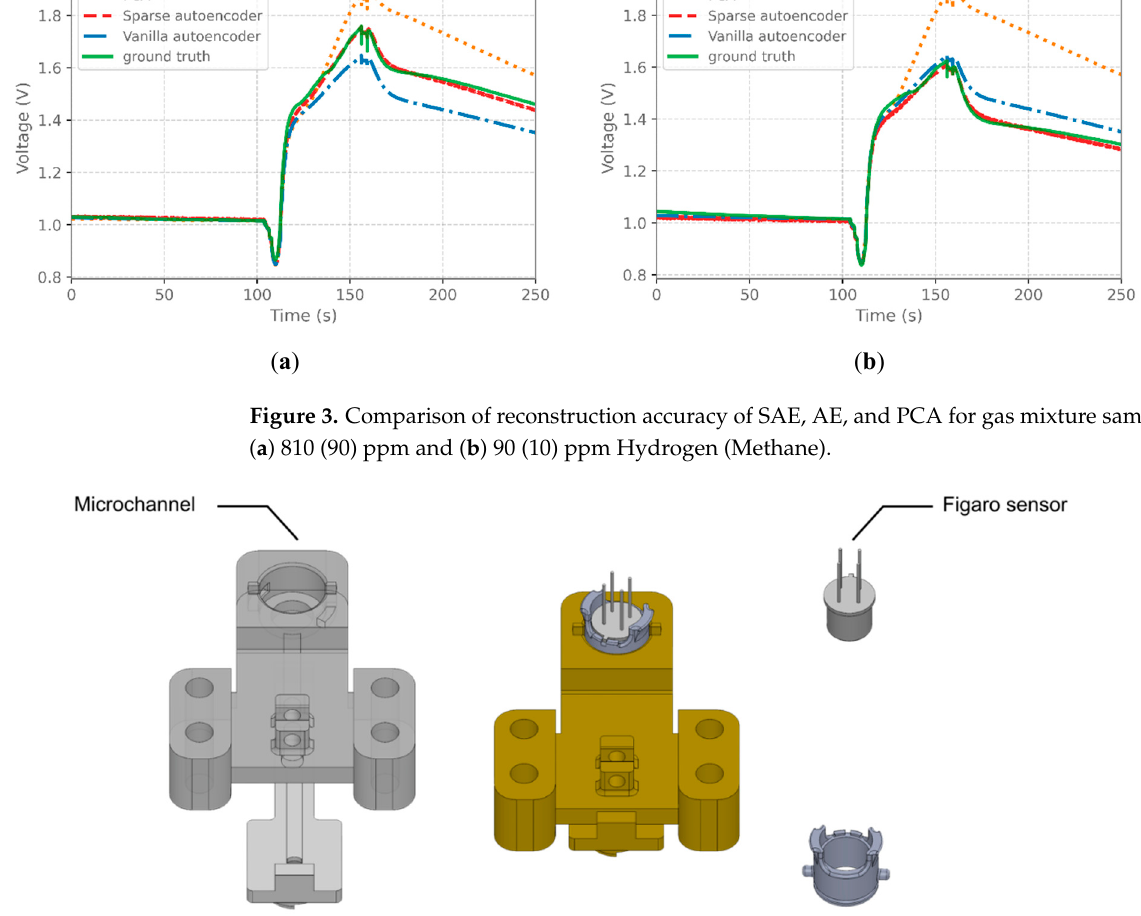
Figure 2. The schematic diagram of the automated experimental setup, designed and built for sam- ple generation and data collection.